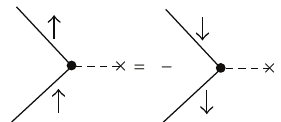
Figure 2: Maki-Thompson diagram. The wavy line represents the pair propagator.